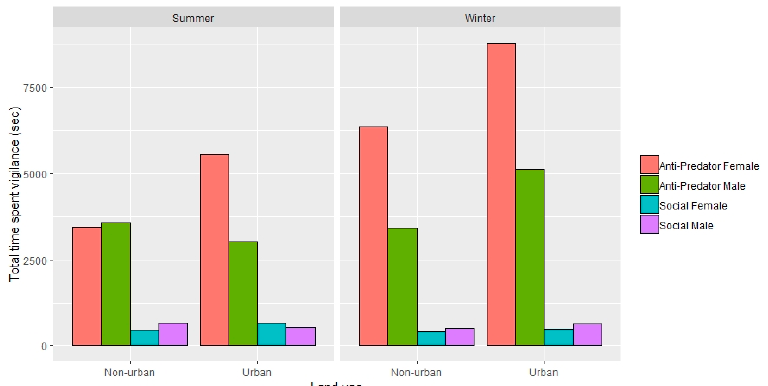
Figure 1. Total time spent displaying anti-predator or social vigilance in eastern grey kangaroos across two regions (south-east Queensland and the Australian Capital Territory).